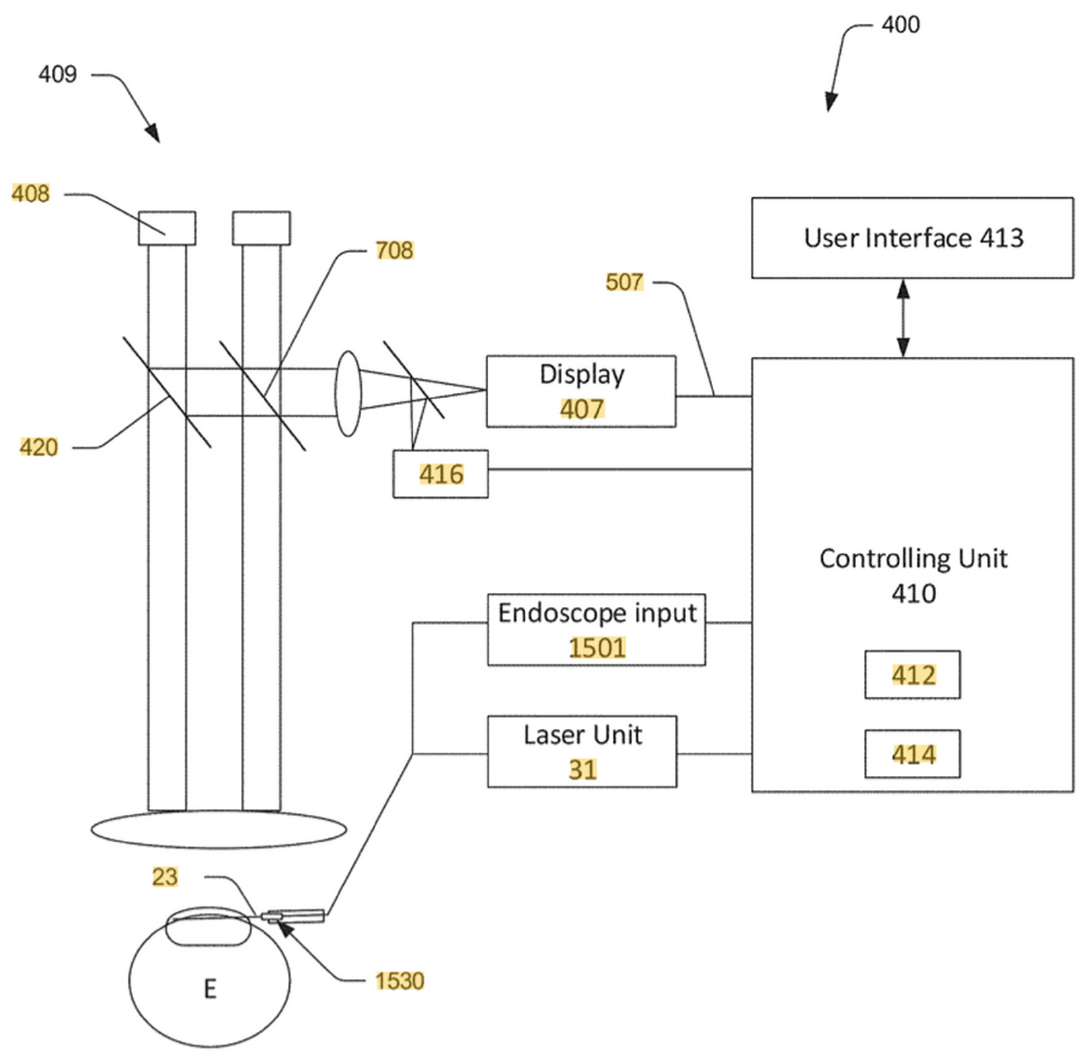
Figure 2. Guided Excimer Laser Trabeculostomy (ELT) GEN 1 Schematic. Berlin, MS, inventor: Image Guidance Methods and Apparatus for Glaucoma Surgery. United States patent US 11,071,647 B2. 27 July 2021.